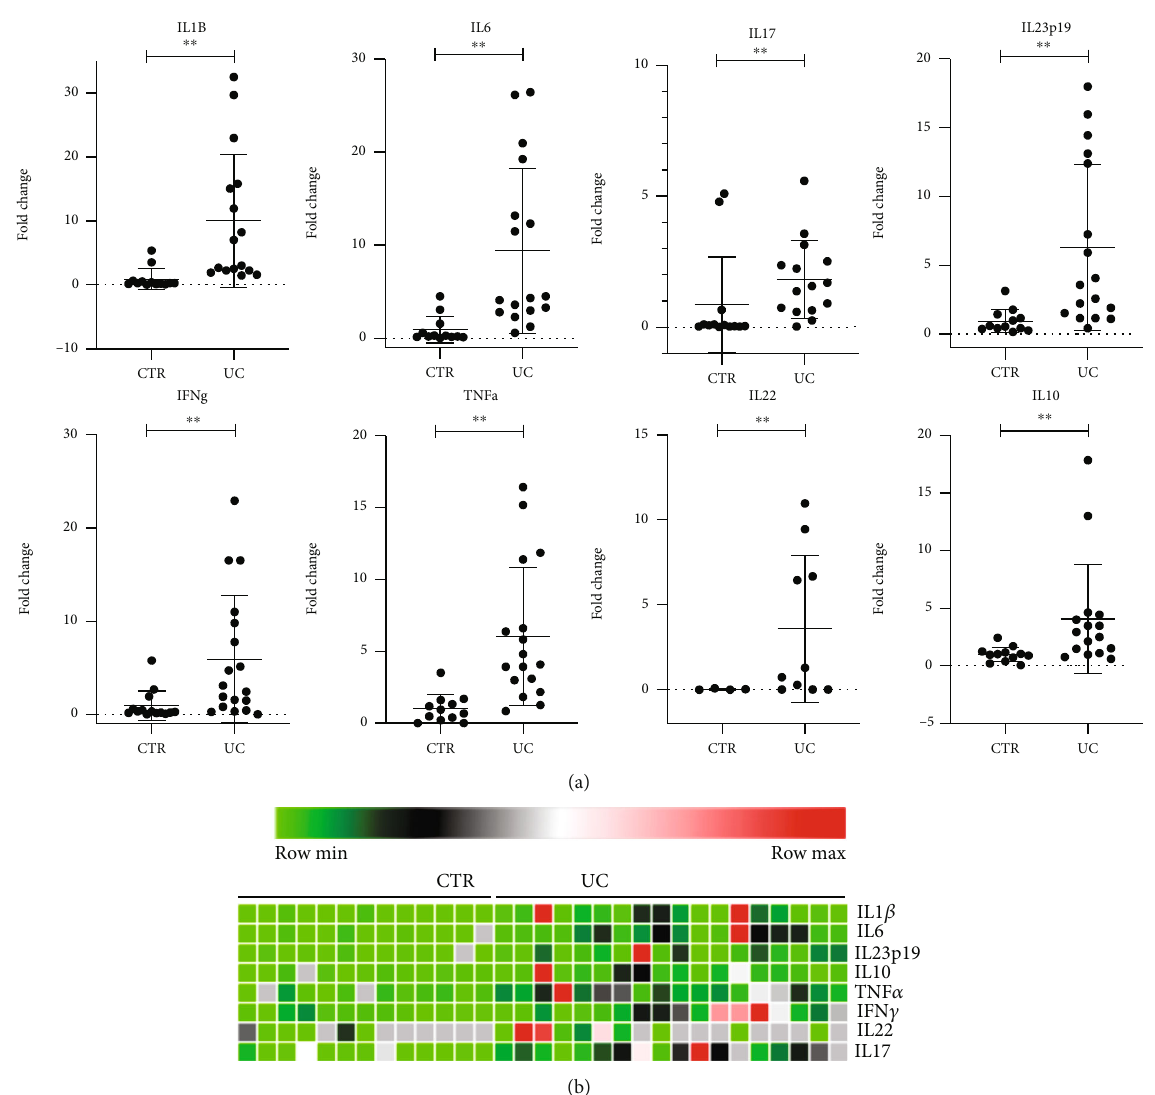
Figure 1: Transcriptional analysis of pro- and anti-in fl ammatory cytokines in UC patients. The transcriptional levels of the cytokines were determined by rt-PCR. (a) Transcriptional levels of IL1 β , IL6, IL17, IL22, IL23p19, IFN γ , TNF α , and IL10 are shown as a fold change. (b) Heat map of the in fl ammatory cytokines. ∗∗ p < 0 : 005 . CTR =control; UC=ulcerative